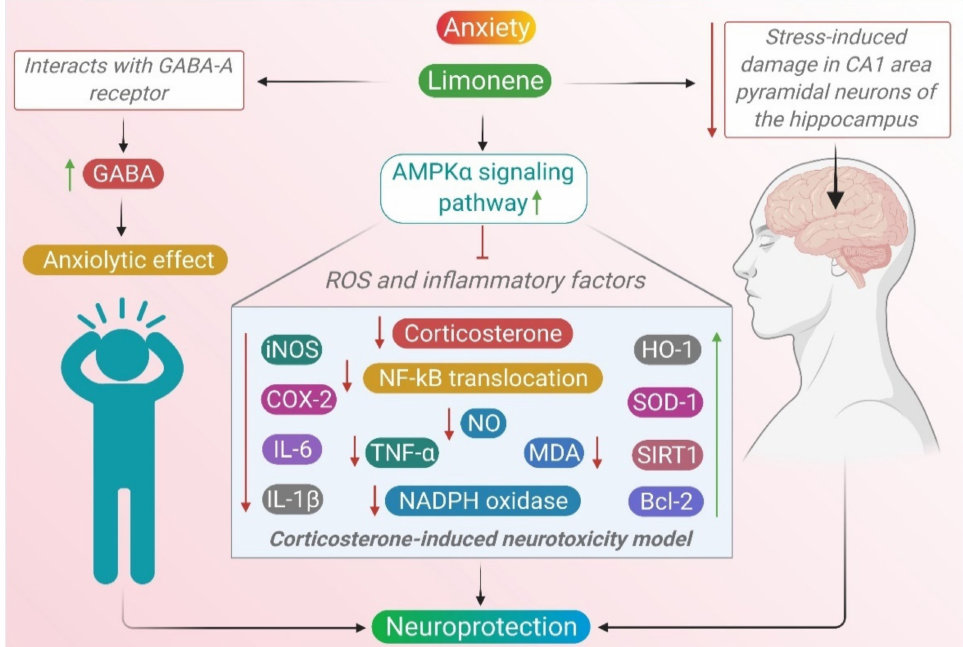
Figure 3. Neuroprotective mechanisms of limonene in